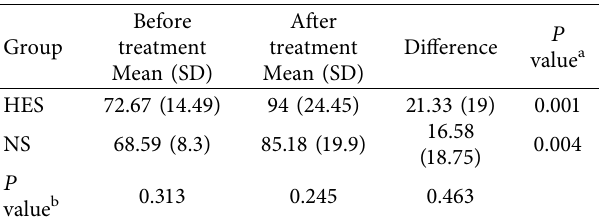
Table 2: Comparison of systolic blood pressure in the normal saline and starch